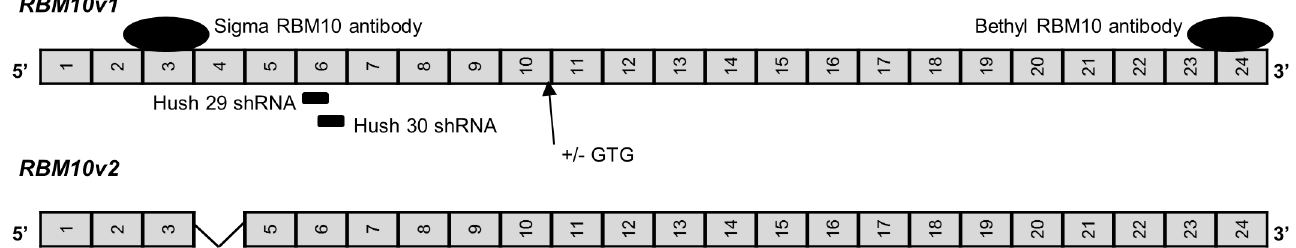
Fig 1. Schematic representation of RBM10v1/v2 exons. Exons are representedby grey boxes outlinedin black. Box sizes are not representative of actual exon size. Black ovals represent approximate location of the epitopes recognized by the antibodiesused in this study. Solid black lines representthe approximate location of shRNA RBM10 targets, which were not variant specific. Corresponding names of antibodiesand shRNA are listed next to their approximate location.Arrow indicatespositionof the GTG codon codingfor the valine residue that can be differentially splicedfrom RBM10 transcripts (last amino acid codedby exon